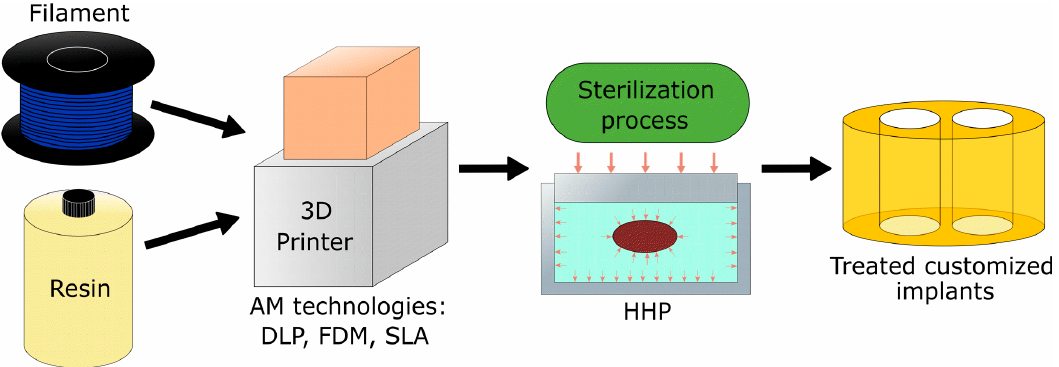
Figure 1. Schematic process for medical devices fabrication (e.g., implants) using AM technologies.